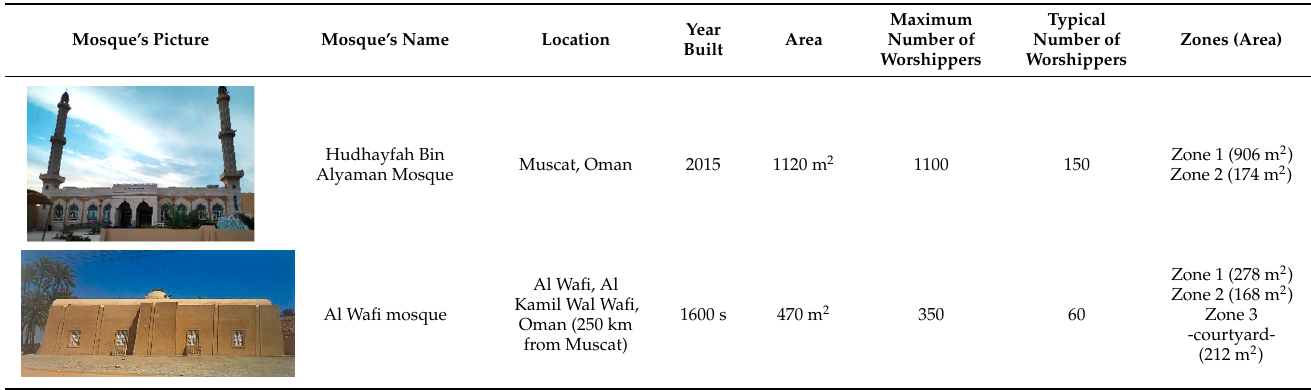
Table 1. A list of mosques for the case study.